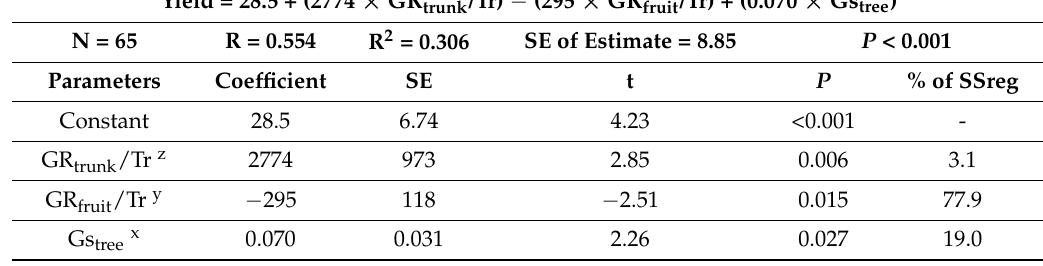
Table 3. Multiple linear regression model and parameters contributing to predict yield in ‘Fuji’ apple trees under deficit irrigation.